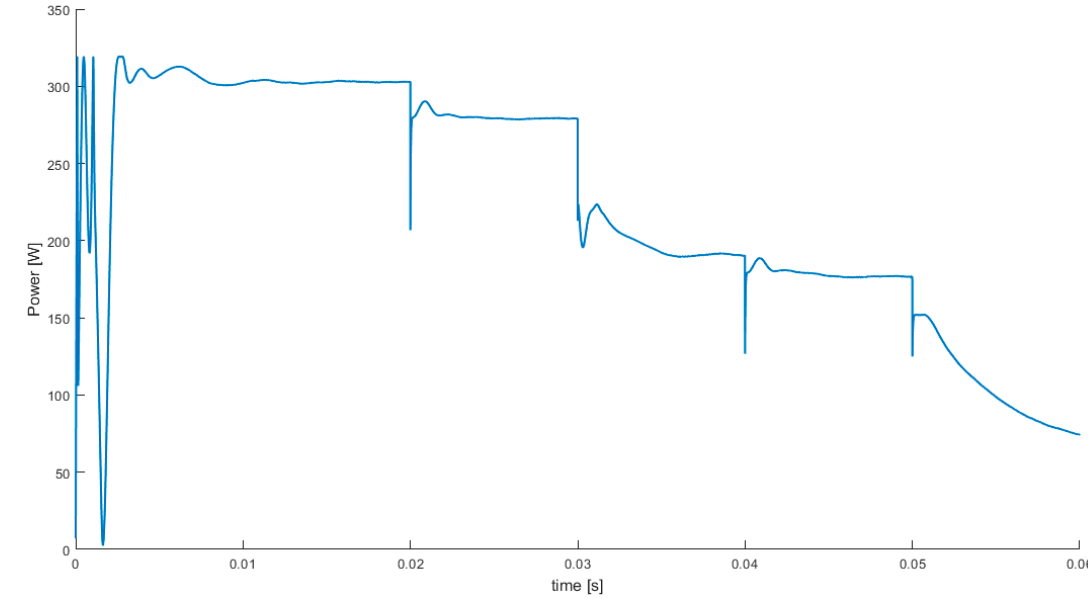
Figure 18. Evolution of PV power over time. Energies 2020 , 13 , x FOR PEER REVIEW